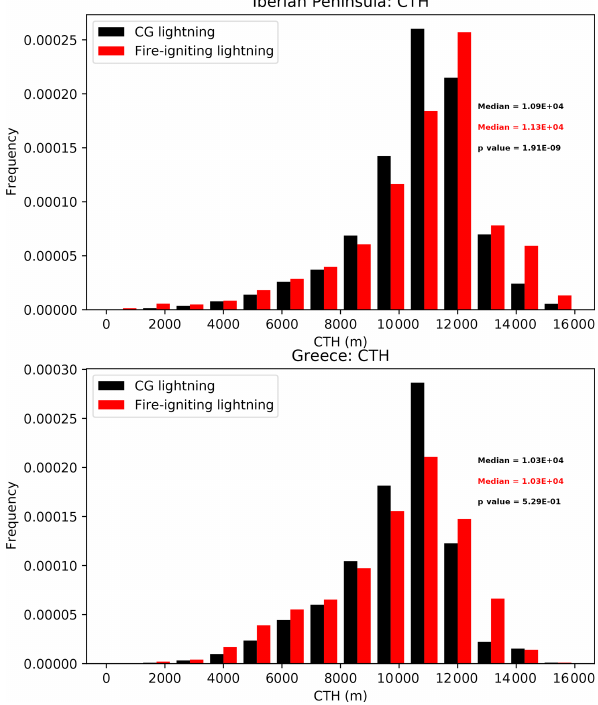
Figure 12. Frequency distribution of the CTH values reported by EUMETSAT based on measurements of the MSG satellites for fire- igniting lightning and all CG lightning over coniferous and mixed forests in the Iberian Peninsula (2012–2015) and Greece (2017–